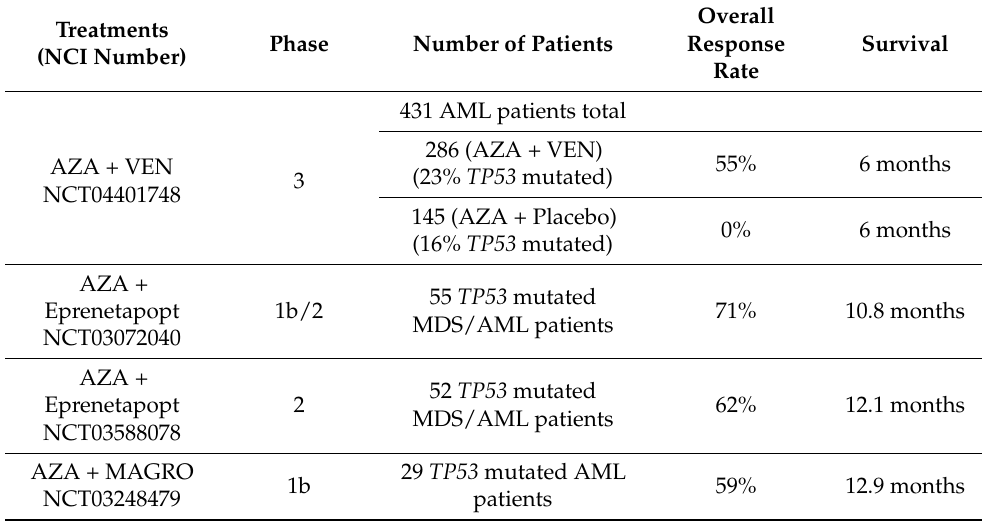
Table 1. Clinical trials in TP53 myeloid